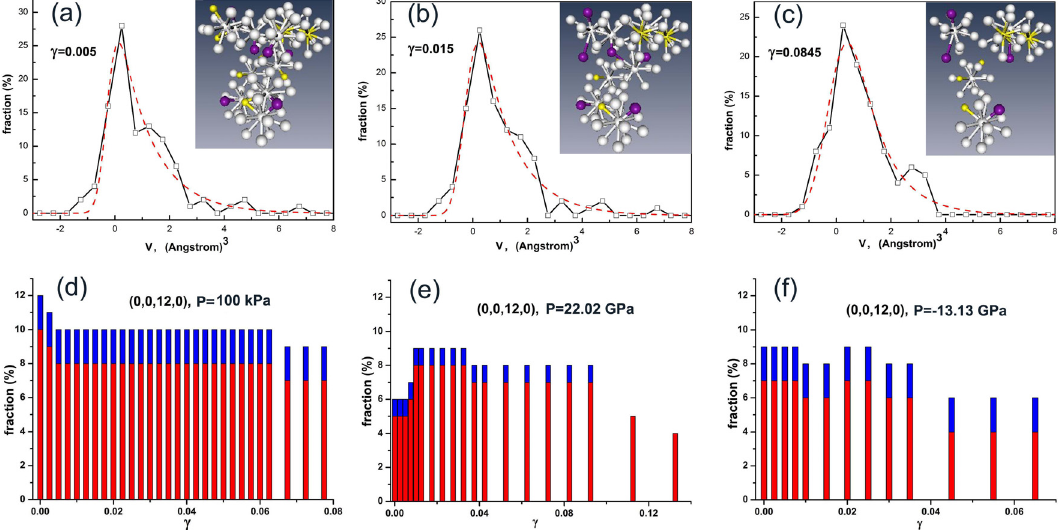
Figure 4. ( a – c ) Histograms of excess volumes v in Fe-Si-B glassy alloy at ambient pressure under shear strains γ = 0.005, 0.015 and 0.0845, respectively. The dashed red curves are fits using a modified exponential function. The insets are icosahedral clusters of atoms with grey, yellow and brown spheres representing Fe, B and Si atoms, respectively. Fe-Si-B glassy alloys at different hydrostatic pressures P.